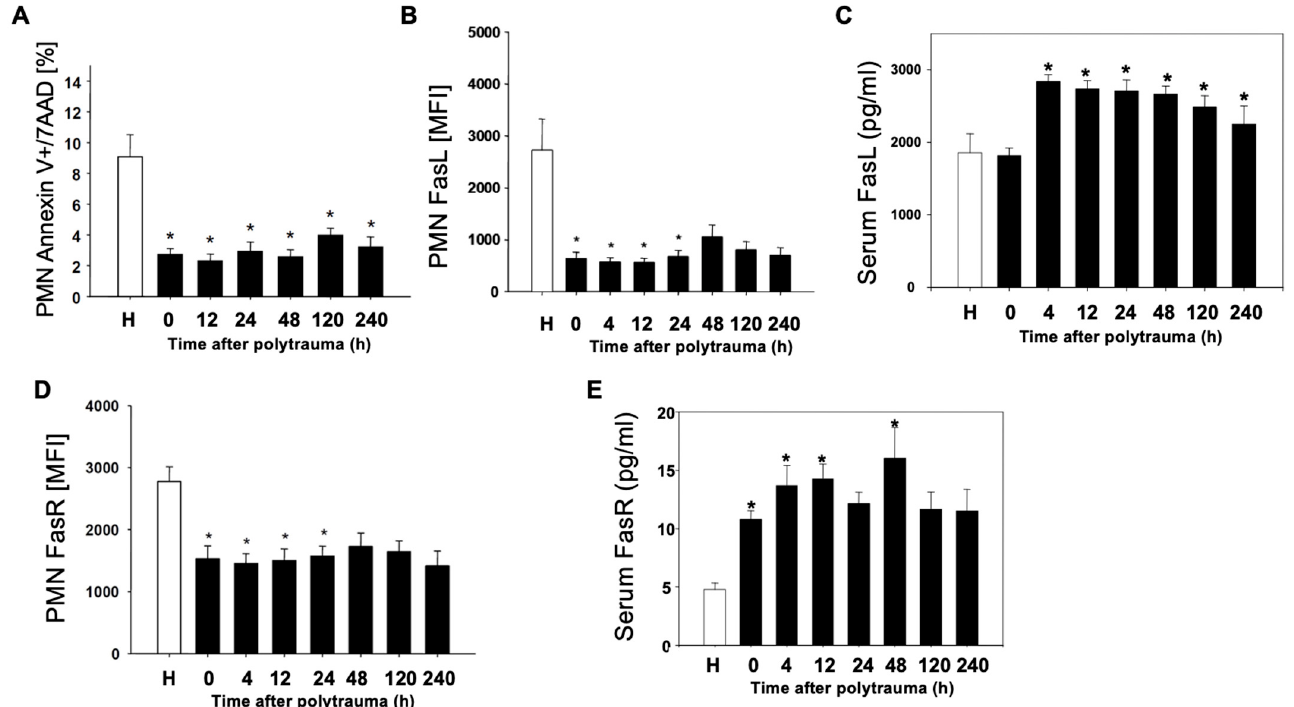
Figure 2. Reduced PMN apoptosis after polytrauma. Time-course of apoptotic events in PMN ( n = 10) post trauma vs. healthy donors ( n = 12). ( A ): Annexin positive, 7AAD negative PMN of polytraumatized patients in percentage in the post-traumatic time course; ( B , D ): Mean fluorescence intensity (MFI) of FasL and FasR on PMN of polytraumatized patients in hours versus healthy controls (H). ( C , E ): Serum FasL/FasR in pg/mL in serum of polytraumatized patients. Results are shown as mean ± SEM. * = p < 0.05 vs. healthy volunteers.